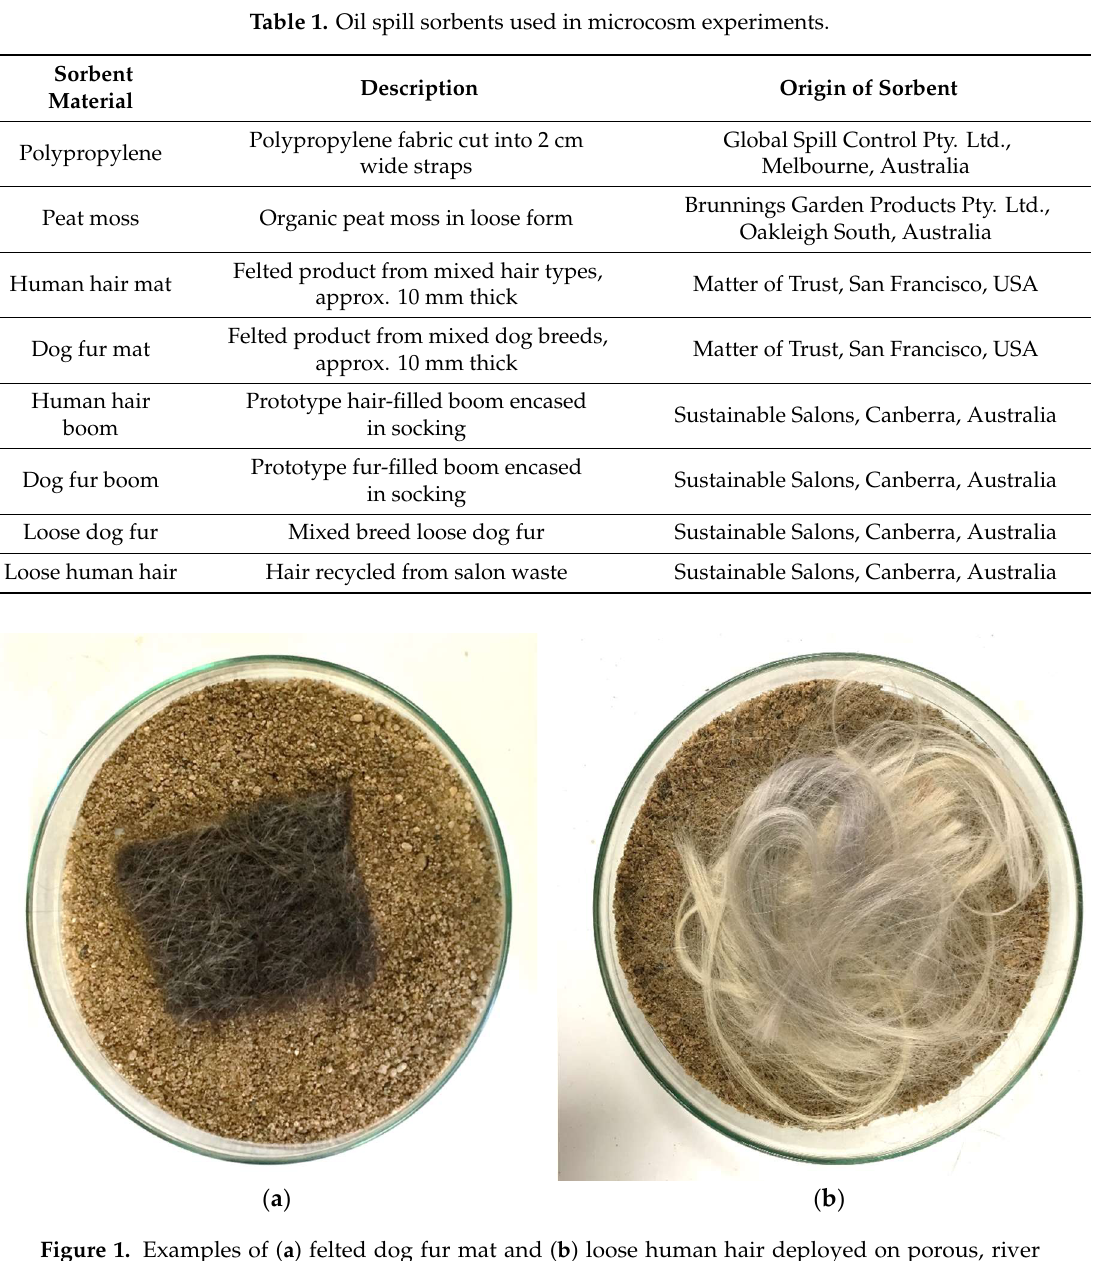
Figure 1. Examples of ( a ) felted dog fur mat and ( b ) loose human hair deployed on porous, river sand surface.